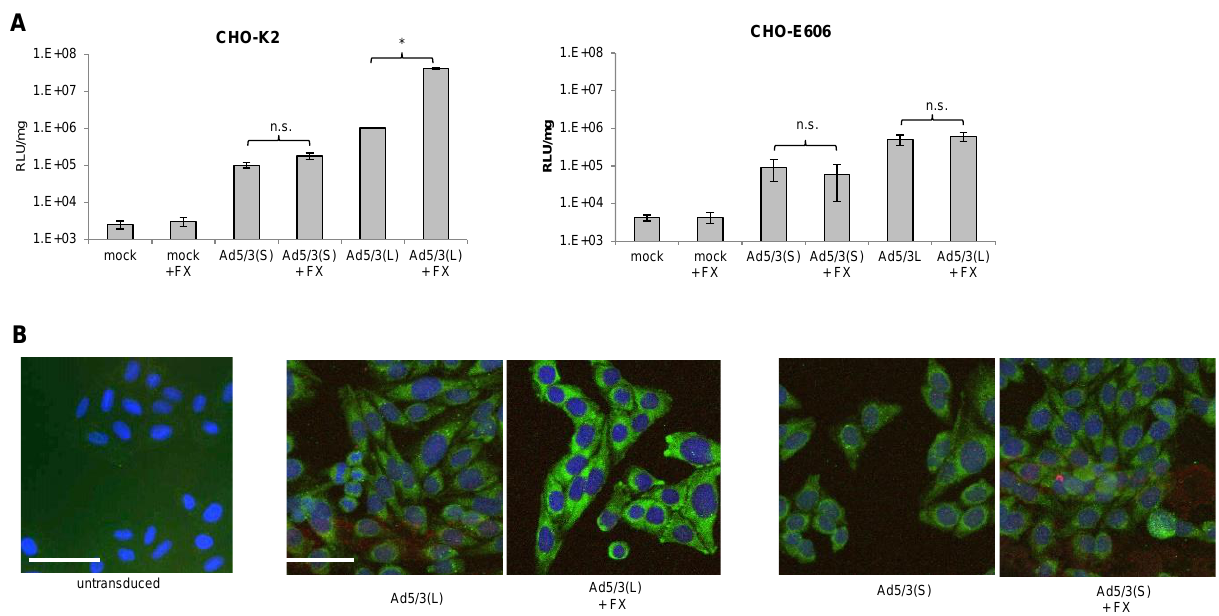
Figure 2. Effect of coagulation factor X on infection of Ad5/3-luc(S) and Ad5/3-luc (L). ( A ) Luciferase activity after transduction of CHO-K2 and sulfation-deficient CHO-E606 cells. Viruses were added to cells at an MOI of 150 pfu/cell with or without recombinant factor X (FX) (8 μg/mL), and luciferase expression was measured 20 h later. n = 3. * p <0.05; n.s.: not significant. ( B ) Detection of viral particles after infection of CHO cells by immunofluorescence analysis for the viral capsid